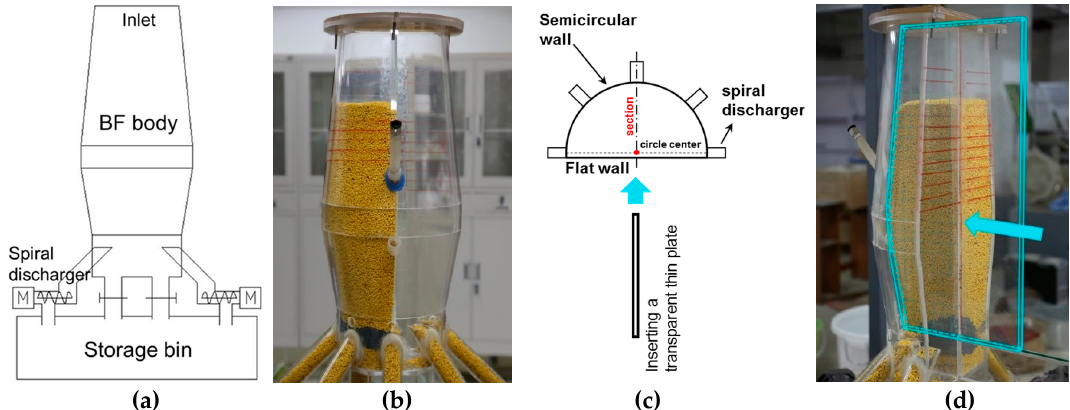
Figure 1. The 3D half-circle blast furnace (BF) model. ( a ) Schematic of the 3D experimental BF model. ( b ) The image of the 3D half-circle experiment BF model. ( c ) Schematic of inserting a transparent plate into the 3D half-circle experiment BF model. ( d ) The image of the vertical section of solid flow obtained by the cutting method in the 3D half-circle experiment BF model.